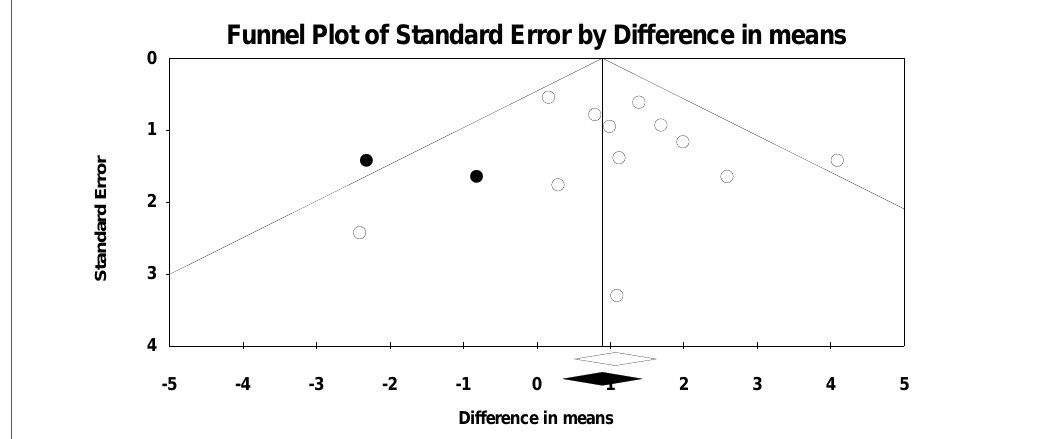
Figure 3. Funnel plot observed and imputed values from Duval and Tweedie’s trim and fill.